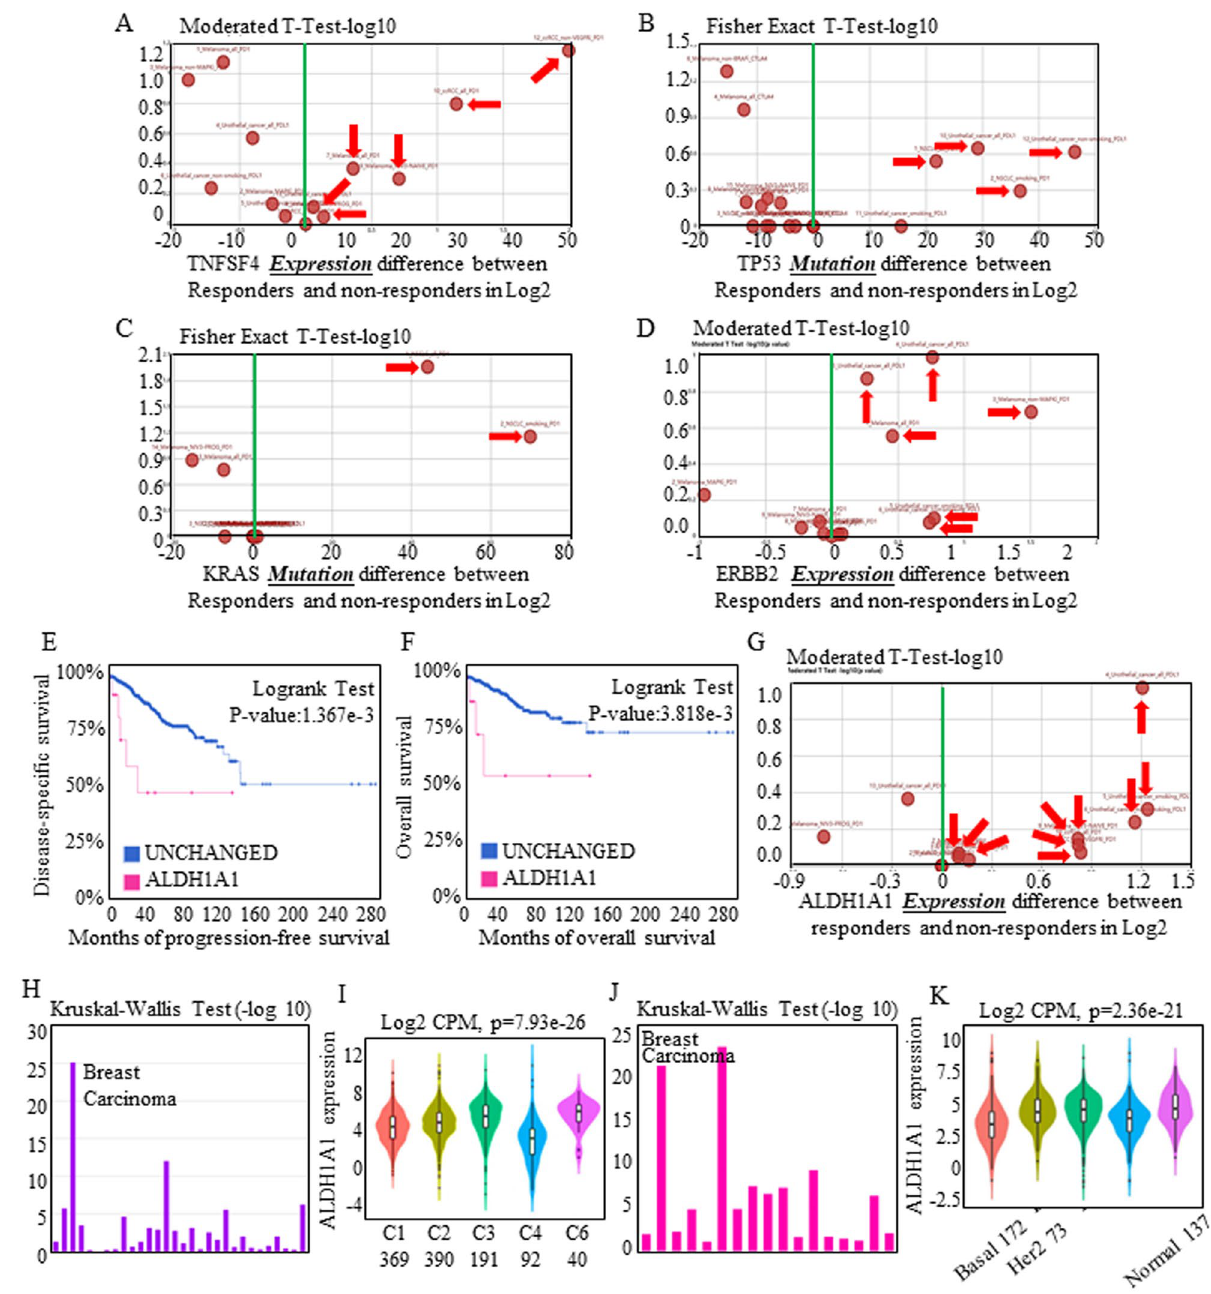
Figure 5. TNFSF4 blockade therapies could be assessed in the stem cell signature-associated mode. The transcriptomic and genomic profiles of pretreated tumor biopsies from responders and non-responders treated with anti-PDL1 and anti-PD1 antibodies were enrolled for analysis. In total, the responders tended to exhibit higher TNFSF4 expression levels, and each study could be reviewed by searching for a certain PMID number (red labeling). Assessment of real-world immunotherapeutic effects indicated that effects related to TNFSF4 ( A ) tended to imply better outcomes and that TNFSF4-associated TP53 ( B ), KRAS ( C ), and ERBB2 ( D ) all indicated better immunotherapy response. Increased ALDH1A1 expression indicated shorter disease-specific survival ( E ) and overall survival ( F ), and ALDH1A1 surprisingly correlated with higher therapeutic response ratios ( G ) through clinical data assessment. ( H , I ) ALDH1A1 was analyzed for its roles in predicting immunotherapy response, and the 5 subgroups C1 (N = 369), C2 (N = 390), C3 (N = 191), C4 (N = 92), and C6 (N = 40) were involved in assessing functional aspects. ALDH1A1 expression dominated in all the subtypes, participating in multiple immune reaction processes. ( J , K ) Associations between ALDH1A1 expression and molecular subtypes across human cancers were also identified, and the signature of increasing ALDH1A1 expression tended to be found in all kinds of breast carcinomas. Specifically, C1 represents wound healing, C2 represents IFN-gamma dominant, C3 represents inflammatory, C4 represents lymphocyte depleted, C5 represents immunologically quiescent and is not shown, and C6 represents TGF-b